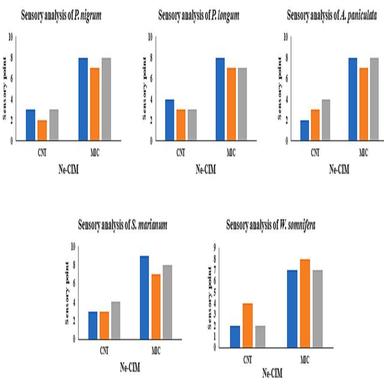
Effect of Ne-CIM on sensory properties of selected herbal raw materials.